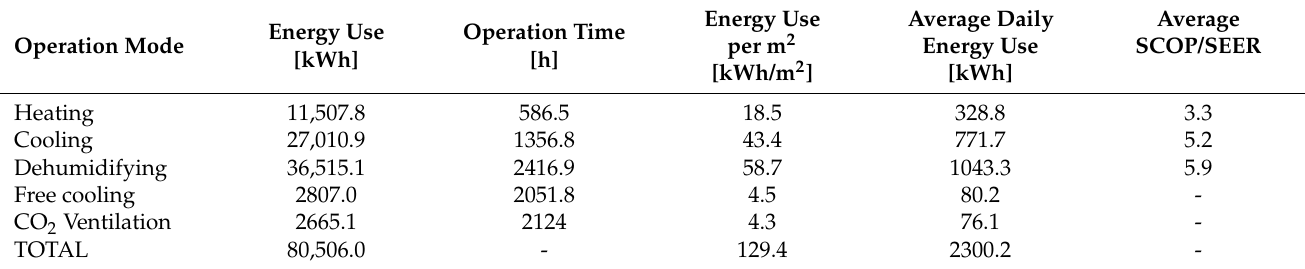
Table 6. Total energy use and average energy efficiency indicators yearly.